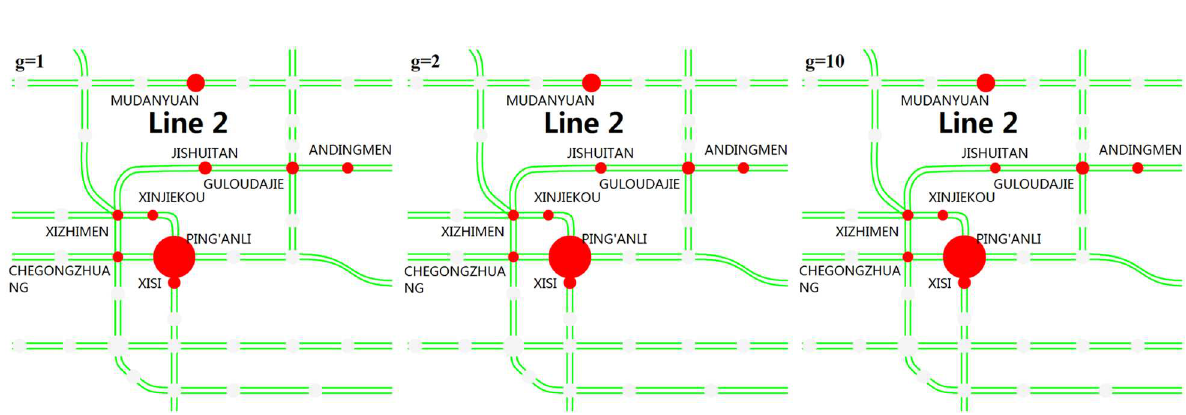
Fig 20. The main stations that passengers choose as their alternative destination stations after JISHUITAN station is closed. The red circles represent the alternative destination stations, and a larger radiusindicatesa larger proportion.